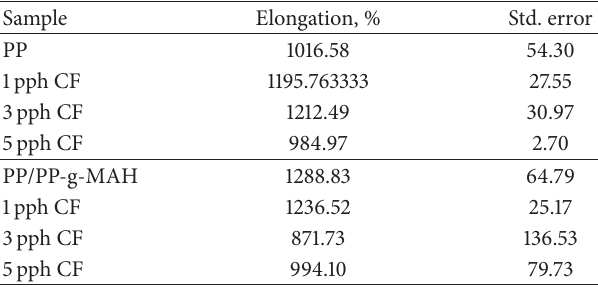
Table4:Tensilestrainatbreakoftheinjectionmouldedcomposites.